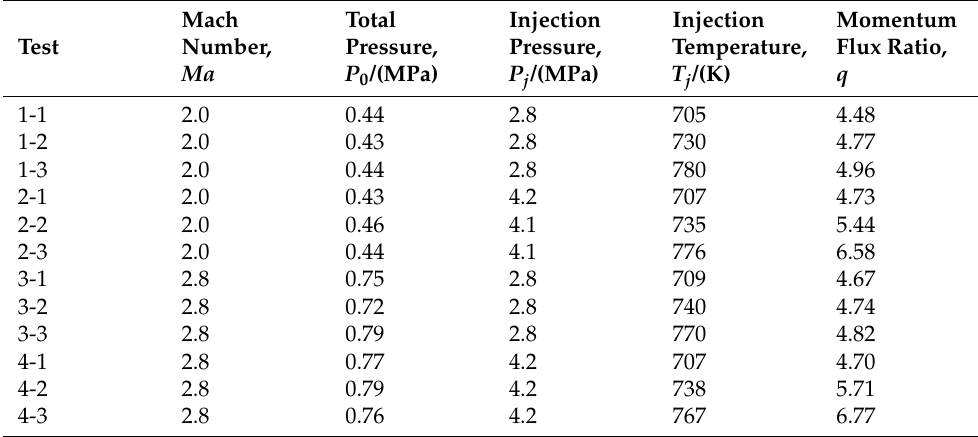
Table 1. Experimental operating